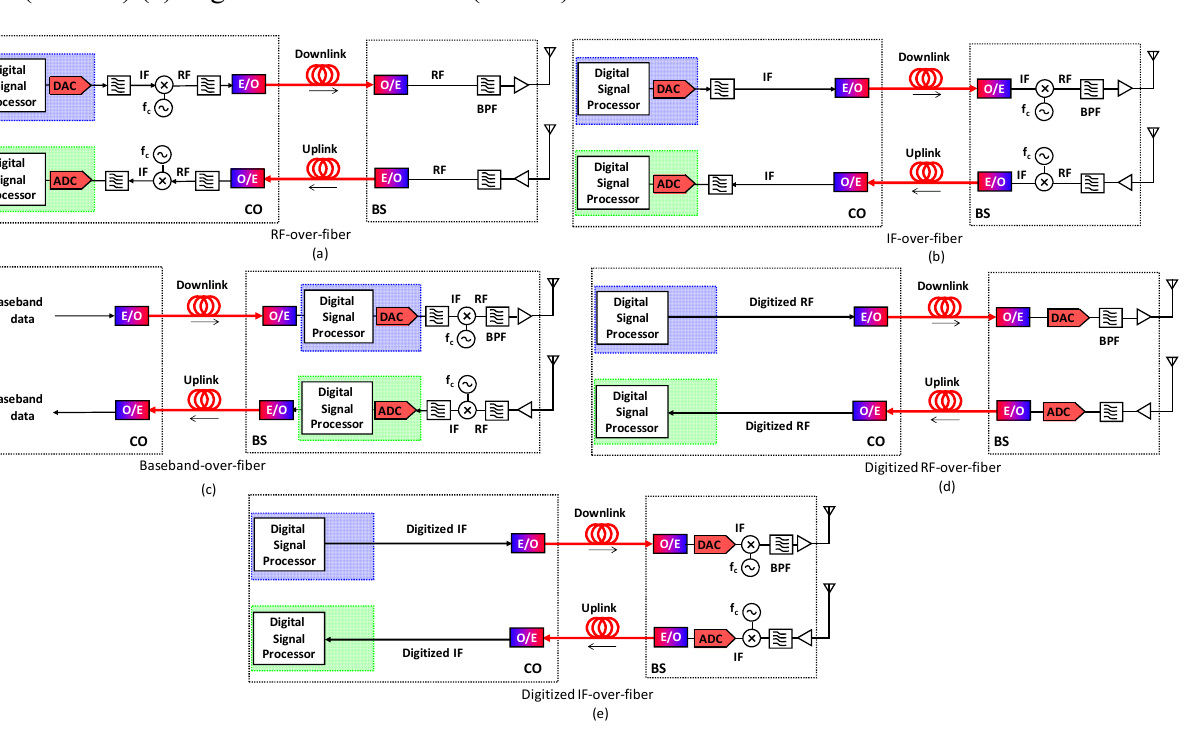
Figure 2. Schematic showing the transport scheme for ( a ) RF-over-Fiber (RFoF) ( b ) IF-over-Fiber (IFoF) ( c ) Baseband-over-Fiber (BBoF) ( d ) Digitized RF-over-Fiber (DRFoF) ( e ) Digitized IF-over-Fiber